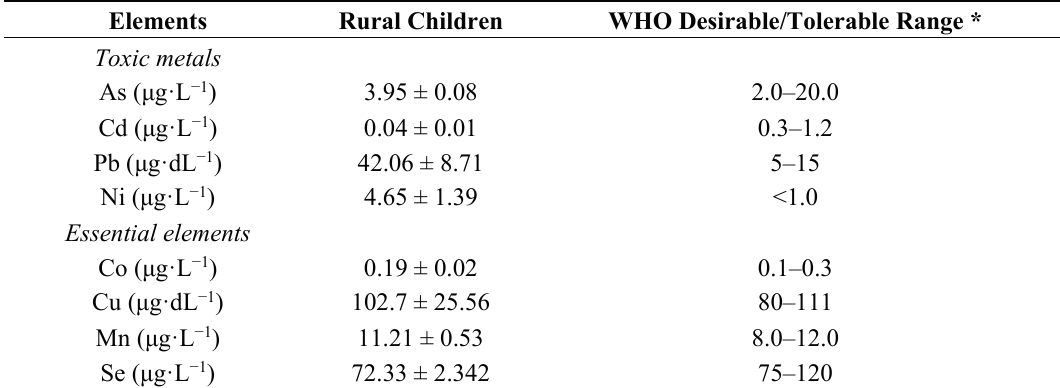
Table 2. Concentrations of toxic metals and essential trace elements in blood of rural children ( n = 20).